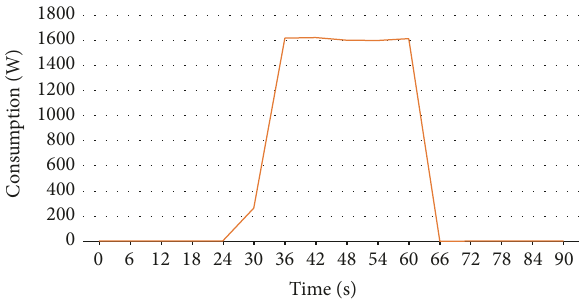
Figure 17: Microwave activation